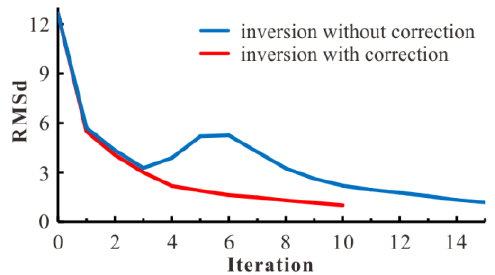
Figure 6. RMSd of gravity inversion. Table 2. RMSm of gravity inversion results.